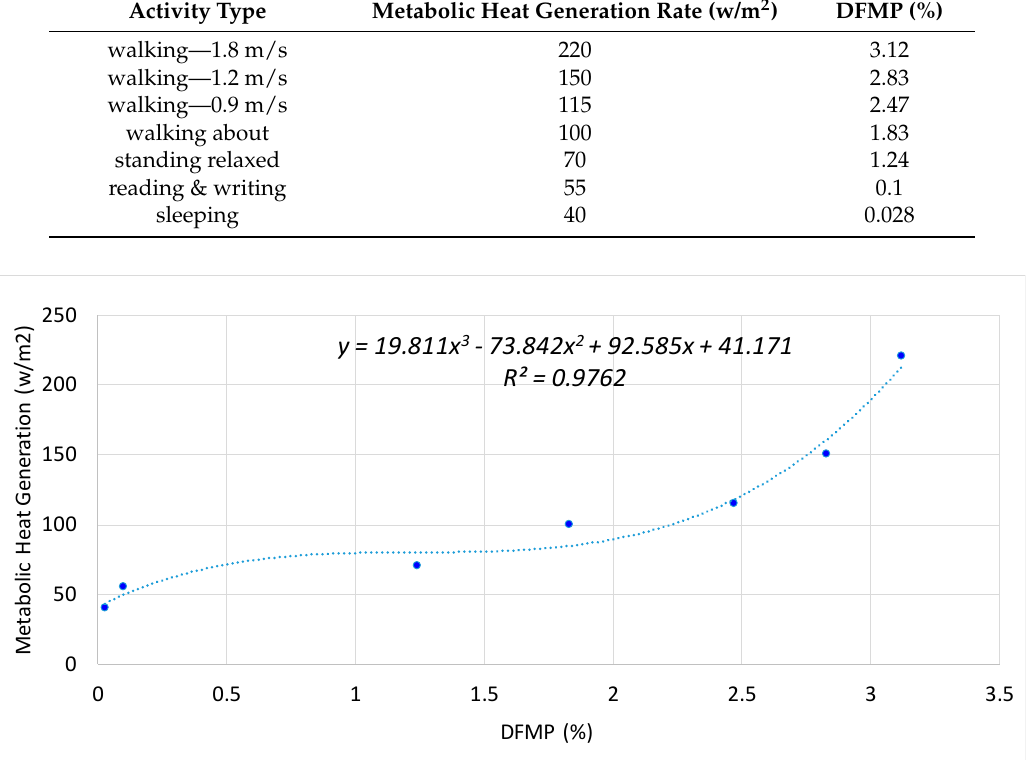
Figure 14. Metabolic Heat Generation Rate vs. DFMP.